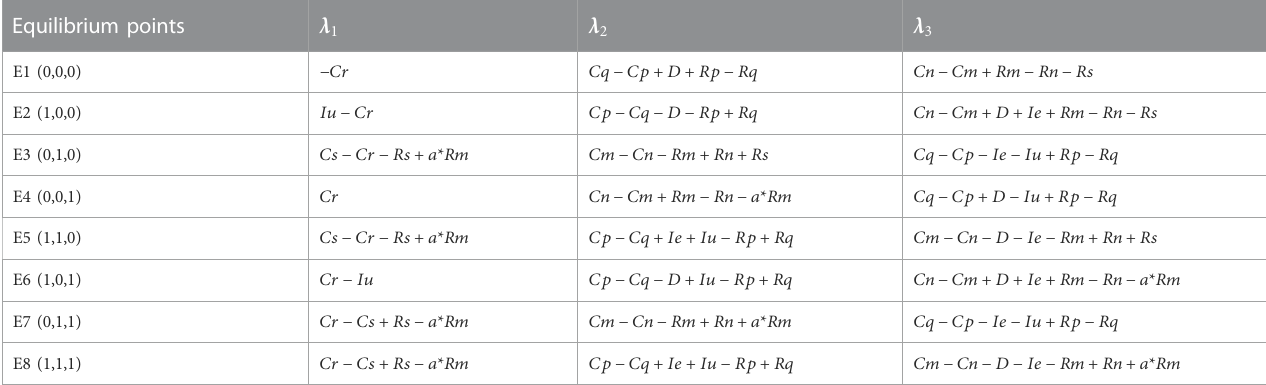
TABLE 3 Eigenvalues of Jacobian matrix at eight equilibrium points. Equilibrium